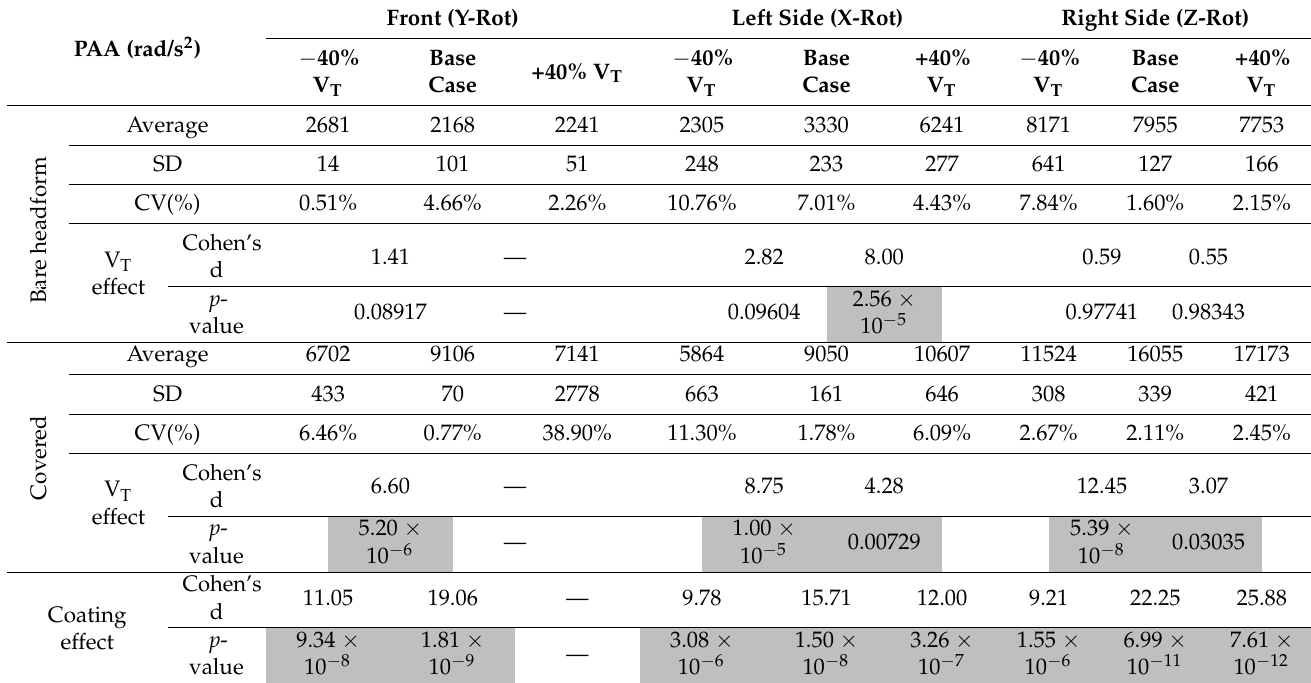
Table 9. Averages, standard deviation (SD), coefficient of variation (CV) and post-hoc results for PAA. p -values < 0.05 portrayed as shaded